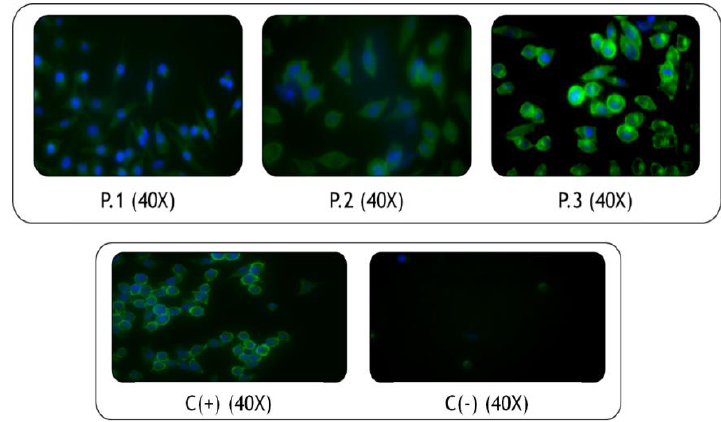
Figure 14. Optical microscopy images of phalloidin (green) and DAPI (blue) staining for representative PUs evaluated on L929 fibroblasts for 24 h. C(+) polystyrene positive control, C( − ) latex negative control. Images were analyzed by ImageJ software.